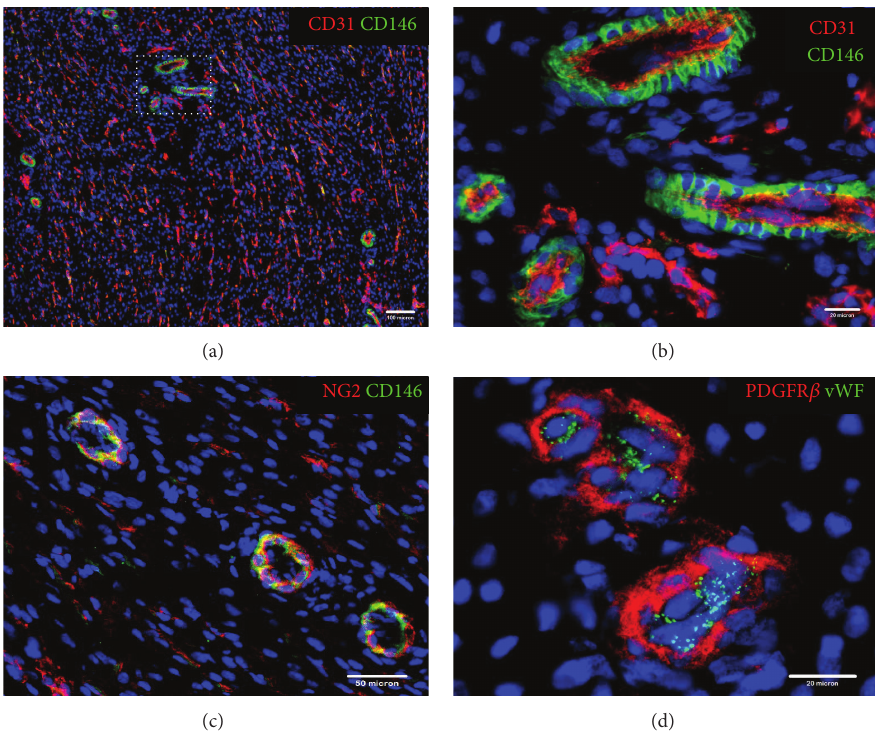
Figure 3: Resident microvascular pericytes in human myocardium. Human myocardium is highly vascularized with numerous microvessels of various sizes and capillaries. Resident heart microvascular pericytes can be identified by a combination of positive (pericyte) and negative (vascular endothelial) cell surface markers. (a) Microvascular and capillary endothelial cells (ECs) were stained by CD31 (red) whilst CD146+ perivascular stromal cells (green) encircled CD31+ ECs (scale bar = 100 𝜇 m). (b) Enlargement of the dotted area in (a) further showed that CD146+ human heart pericytes (hHPs, green) closely surround CD31+ ECs (red) (scale bar = 20 𝜇 m). (c) CD146+ hHPs coexpressed pericyte marker NG2 (scale bar = 50 𝜇 m). (d) hHPs expressing pericyte marker PDGFR 𝛽 (red) encircled vWF+ ECs (green) (scale bar = 20 𝜇 m). Nuclei are stained in blue by DAPI (4 󸀠 ,6-diamidino-2-phenylindole).